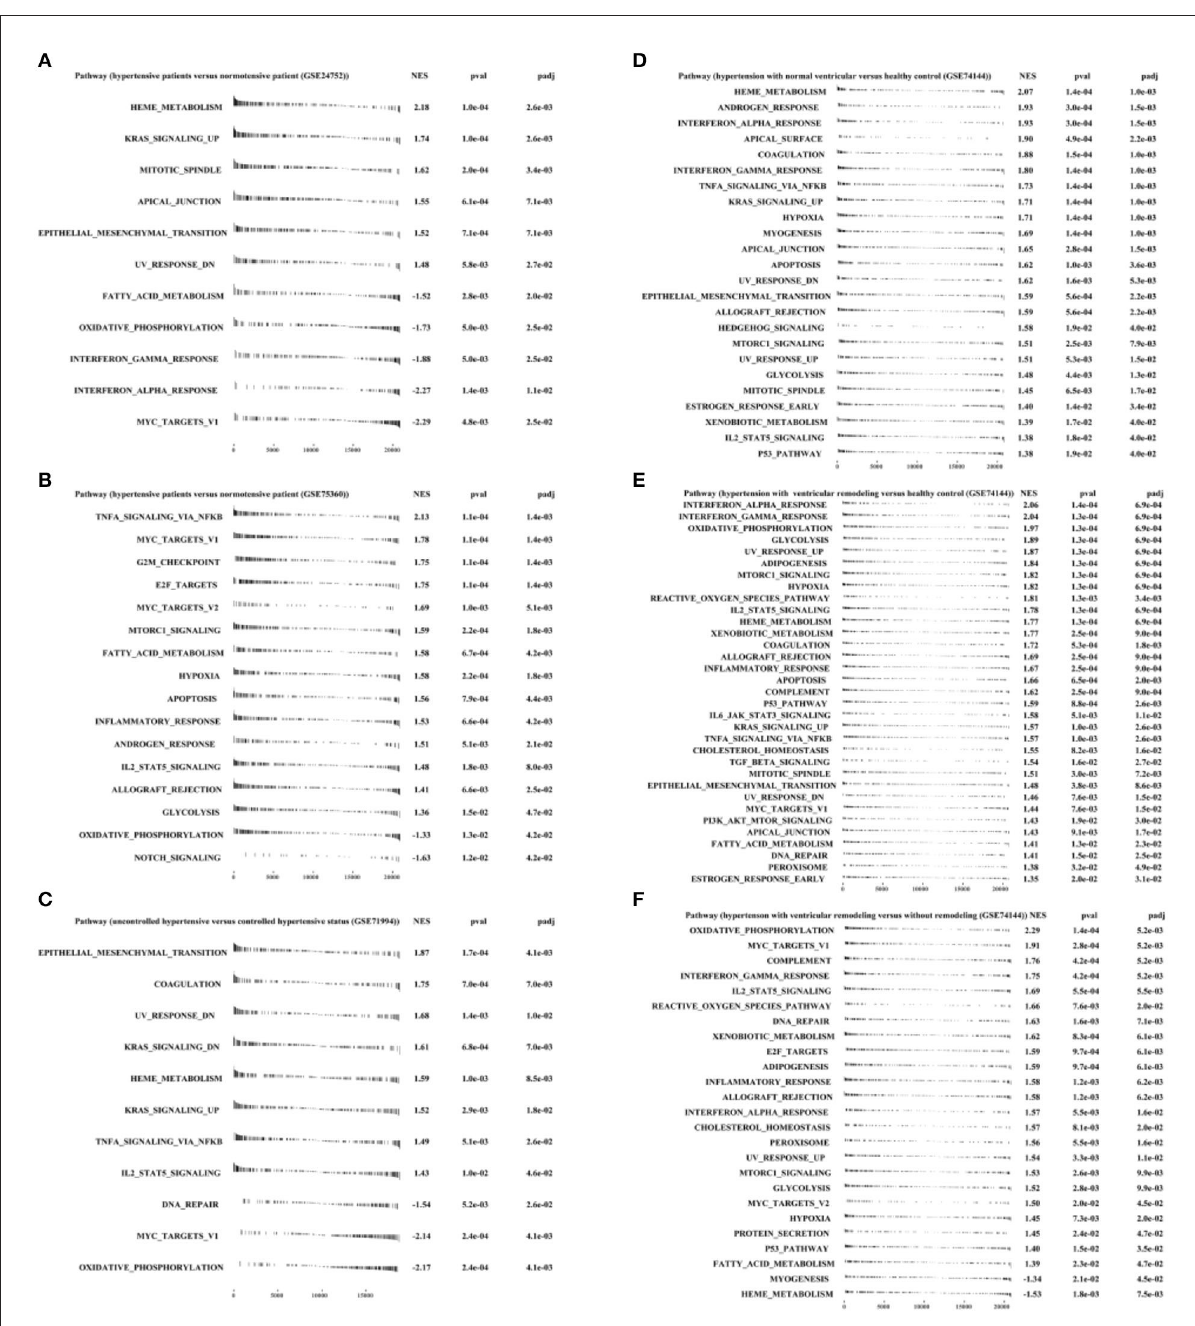
FIGURE4 Fast pre-ranked gene set enrichment analysis (GSEA) based on h.all.v7.4.symbols.gmt (http://www.gsea-msigdb.org/gsea/msigdb/collections. jsp#H) by “fgsea” R packages. (A) GSE24752: hypertensive ( n = 3) vs. normotensive ( n = 3). (B) GSE75360: hypertensive ( n = 10) vs. normotensive ( n = 11). (C) GSE71994: uncontrolled hypertensive ( n = 20) vs. controlled hypertensive ( n = 20). (D) GSE74144: hypertensive patient with normal left ventricular ( n = 14) vs. normal control ( n = 8). (E) GSE74144: hypertensive patient with left ventricular remodeling ( n = 14) vs. normal control ( n = 8). (F) GSE74144: hypertensive patient with left ventricular remodeling ( n = 14) vs. hypertensive patient with normal left ventricular ( n =